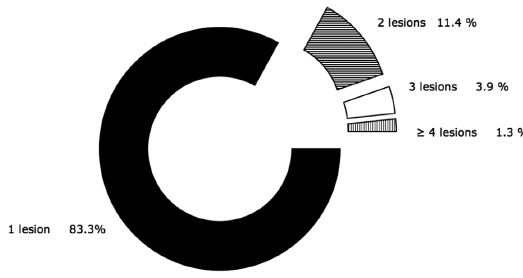
Incidence of BCC lesions in treated